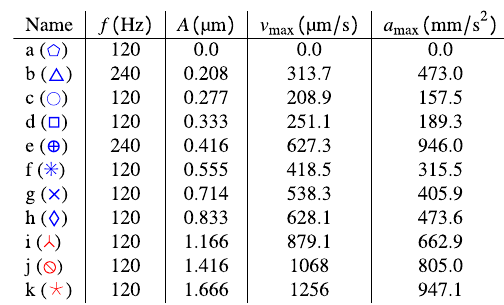
Table 2. Forcing parameters imposed on the system. The maximum speed and acceleration imposed on the drum are v max = ( 2 π f ) A , and a max = ( 2 π f ) 2 A respectively. Note that the data {a, b, c, d, e, f, g, h} have blue markers in Fig. 2b, whereas the data {i, j, k} have red